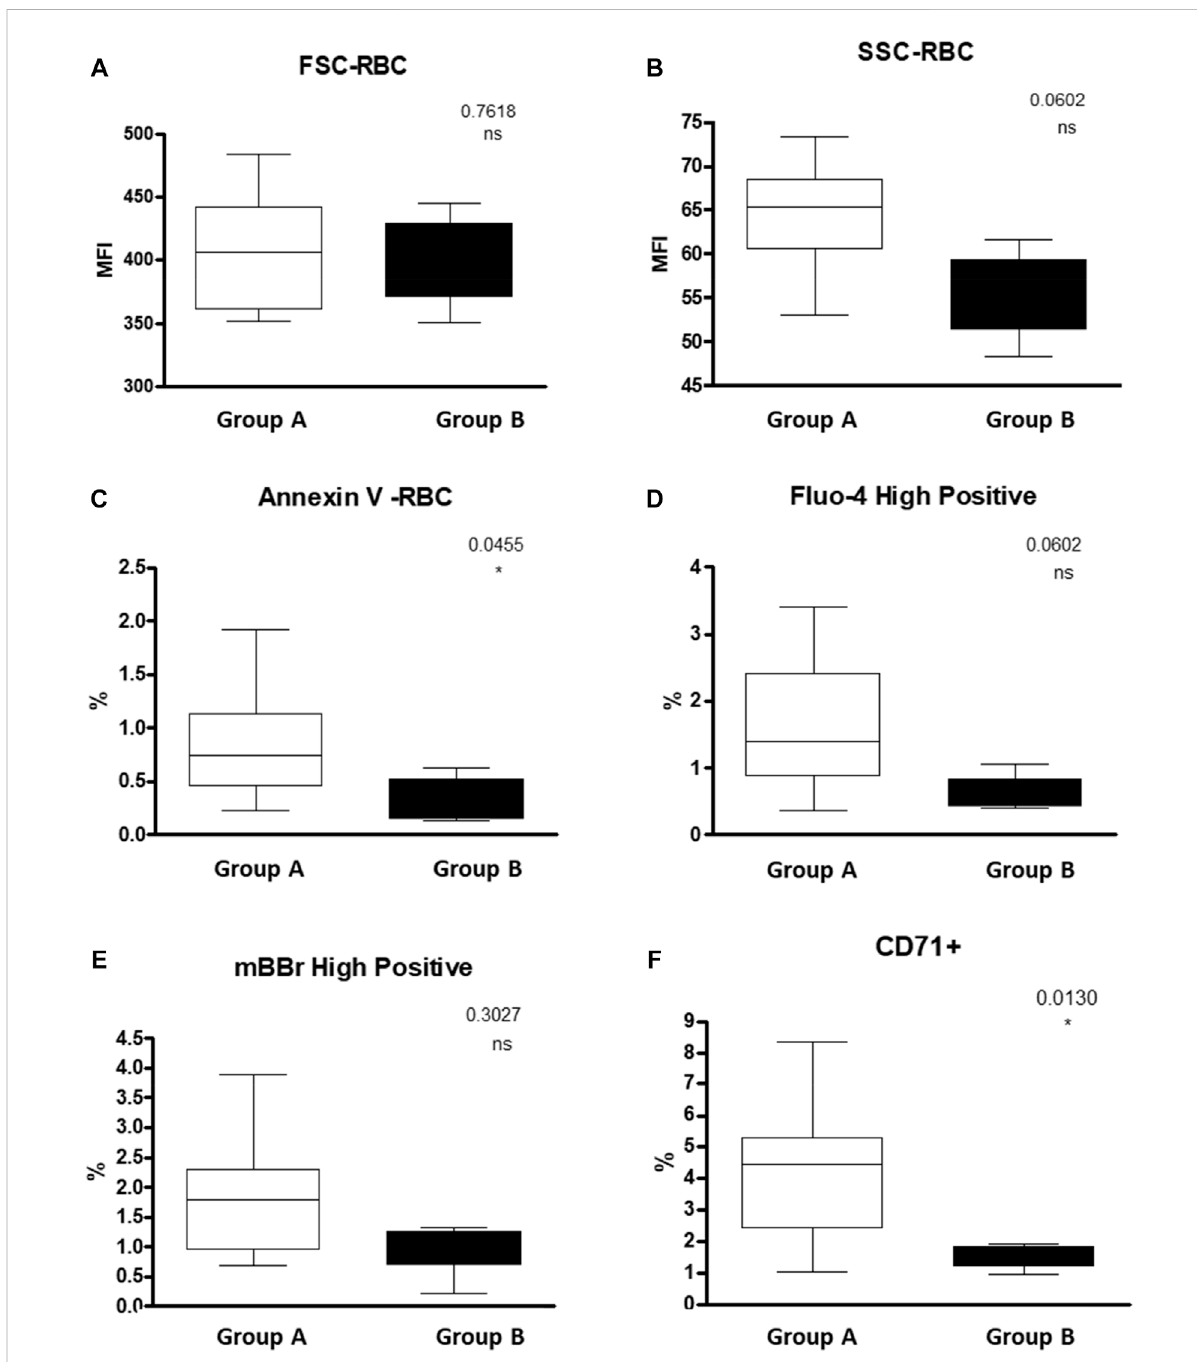
FIGURE 4 RBC properties of SCD patients Asplenic/hyposplenic compared to Hypersplenic using Flow cytometry: (A) + (B) FSC and SSC of RBC; (C) Annexin V positive RBC; (D) fl uo-4 high-positive RBC; (E) MBBR high-positive RBC; (F) CD71 positive RBC. Group (A) patients with asplenia/ hyposplenism, Group (B) patients with